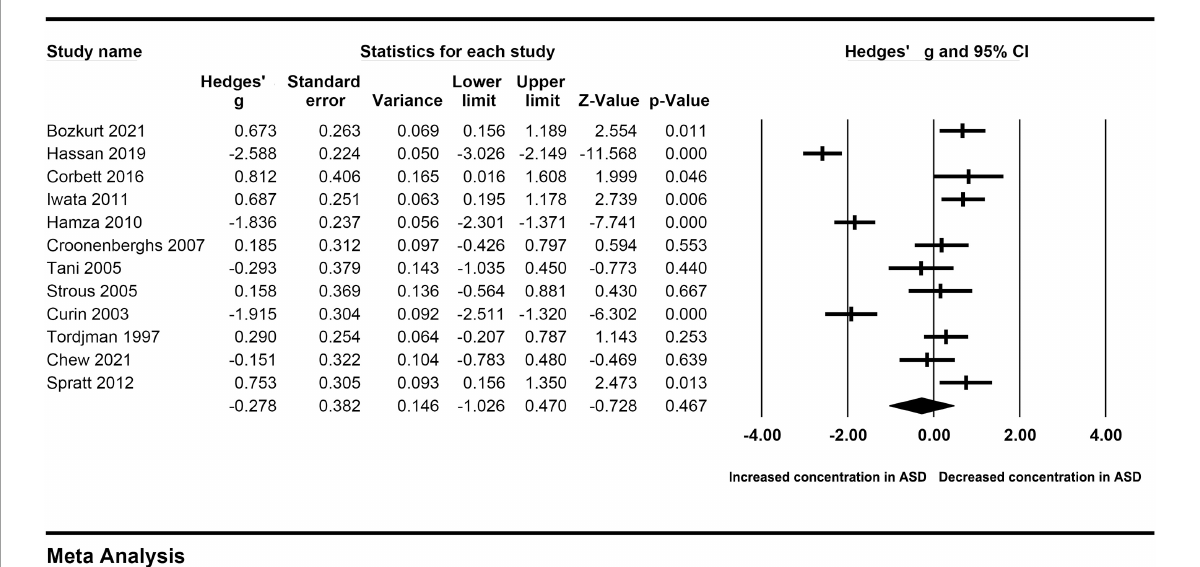
FIGURE2 Forest plot for the random-effect